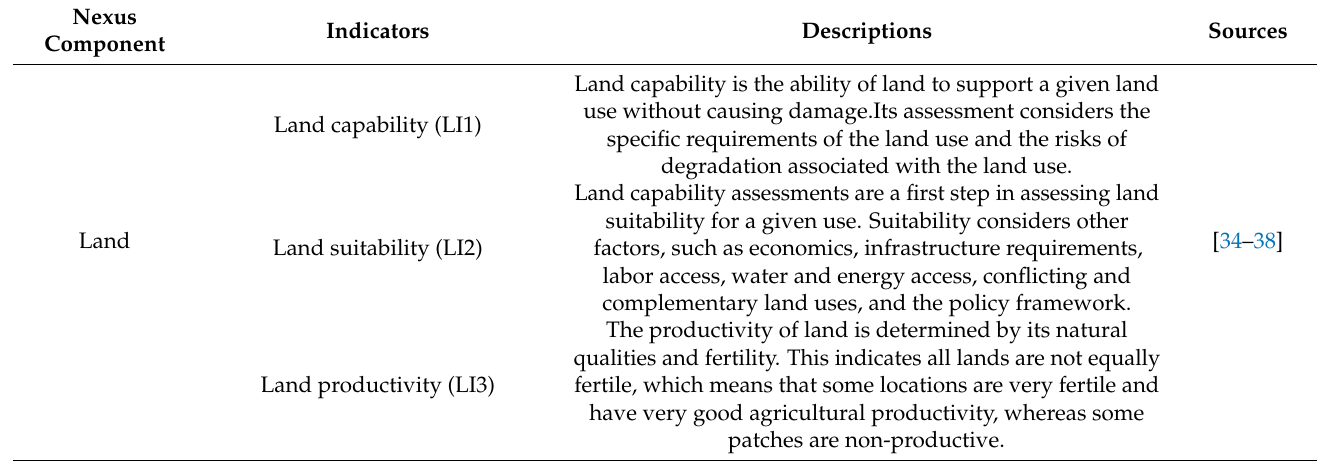
Table 3. Component of Sustainable livelihood